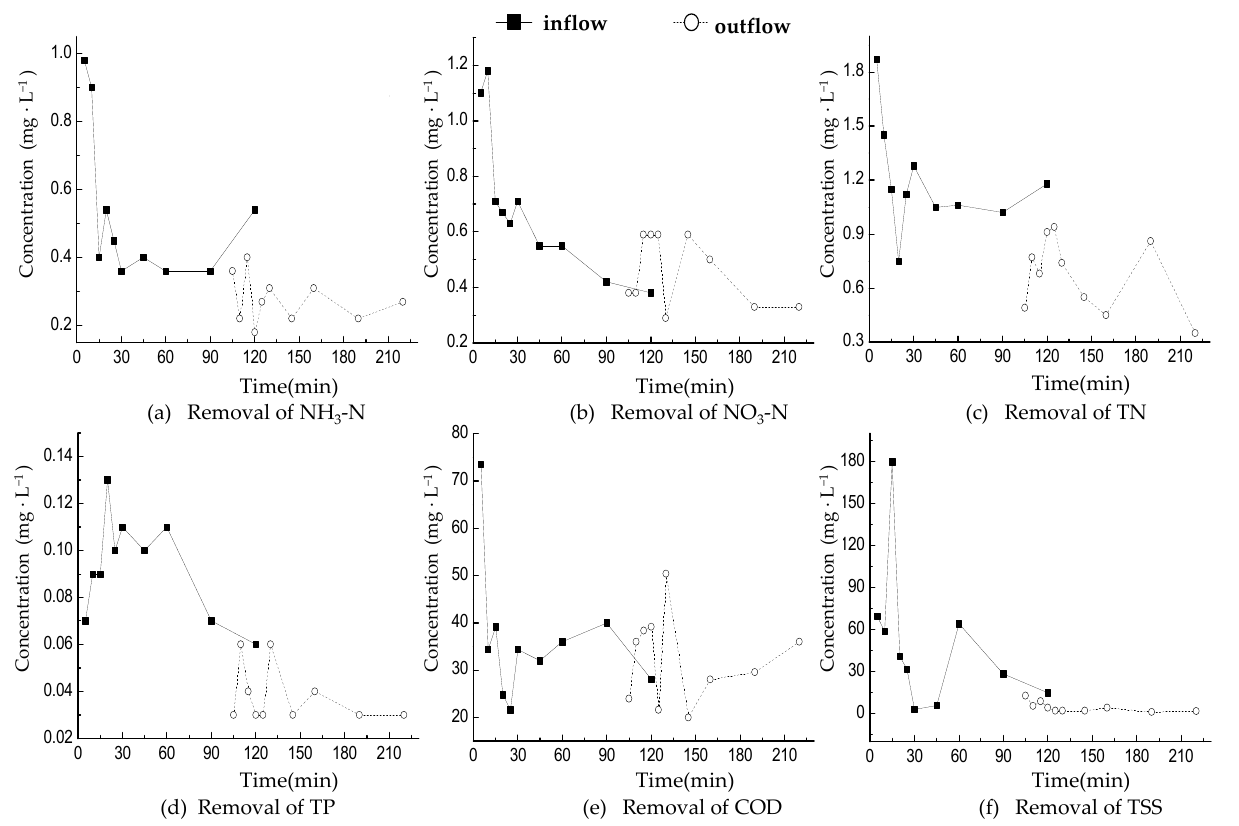
Figure 6. The time-variation of pollutant concentrations in inflow and outflow.